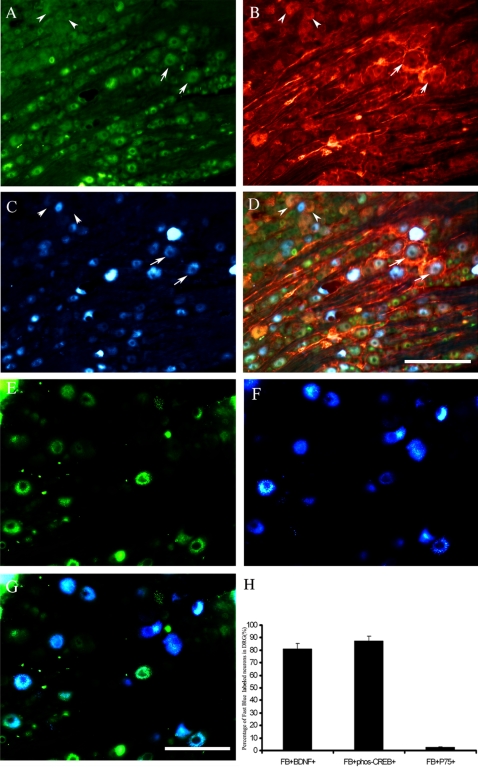
Retrograde tracing combined with immunohistochemistry of BDNF (green in A), p75NTR (red in B) or p-CREB(green in E).FB+ neurons were blue- (C, F) and most of FB+ regenerating neurons were large-sized neurons. The section in Fig. 3A, B, C was triple-labeled with BDNF and p75NTR. Most FB+ neurons were immunoreactive for BDNF (arrows in A and C ,H). Most FB+ neurons did not express p75NTR but some were surrounded with p75NTR+ satellite glial cells (arrows, B, C and D). Neurons expressing significant level of p75NTR were not FB+ (arrowheads, B, C and D). A subpopulation of large sensory neurons was p-CREB+ (E, green). Most FB+ neurons were also p-CREB+ (E and G). H: Group data showed the colocalization percentage of FB+ neurons with BDNF, p-CREB or p75NTR, respectively (n = 5). Scale bar = 100 µm in D applies to A, B, C. Scale bar = 50 µm in G applies to E, F.